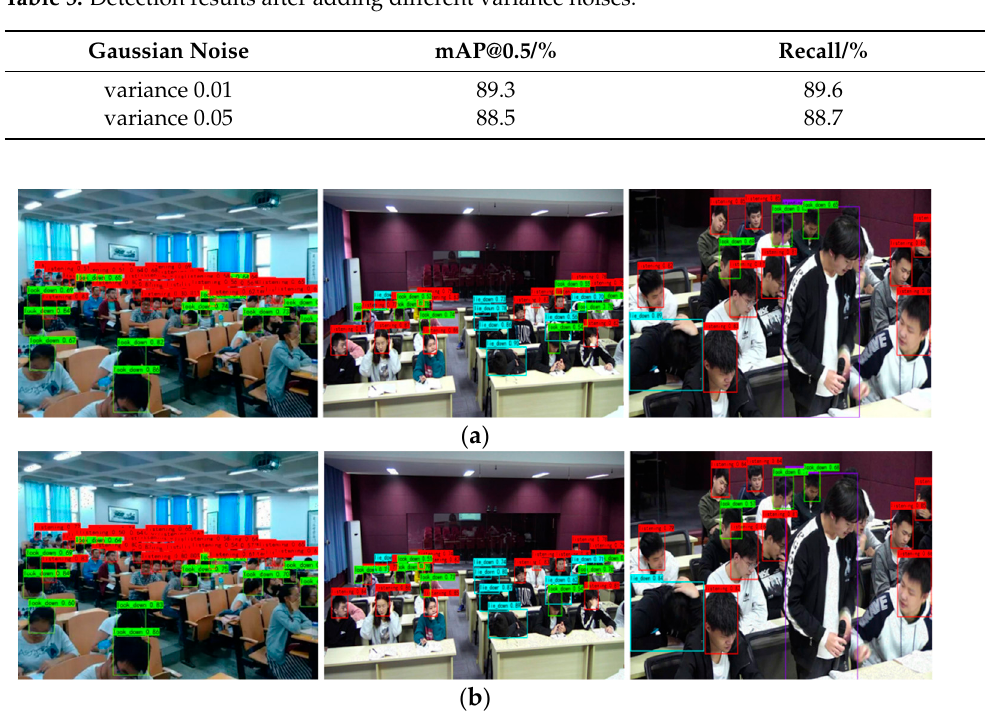
Figure 17. Detection effect after adding noise. ( a ) variance 0.01. ( b ) variance 0.05. Table 5. Detection results after adding different variance